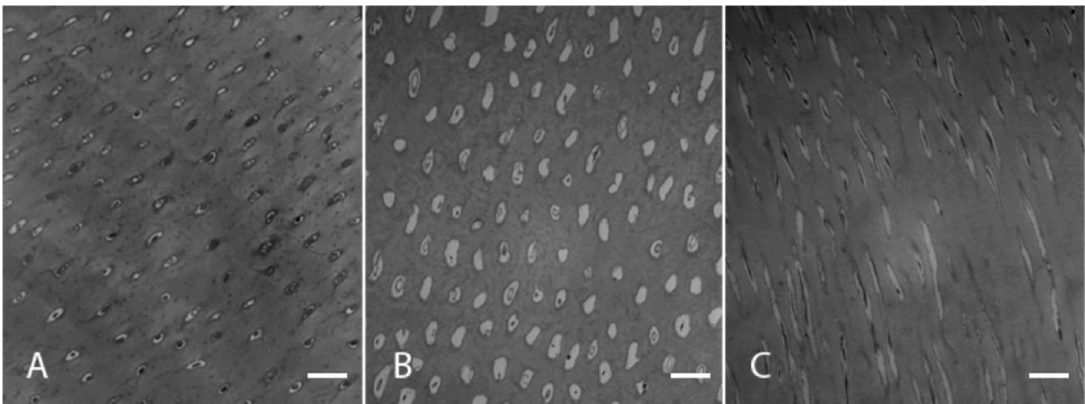
Figure 3. Morphological analysis of dentin from healthy and OI donors. ( A ): Dentin from healthy donors; ( B , C ): Dentin from OI donors without odontoblastic process.